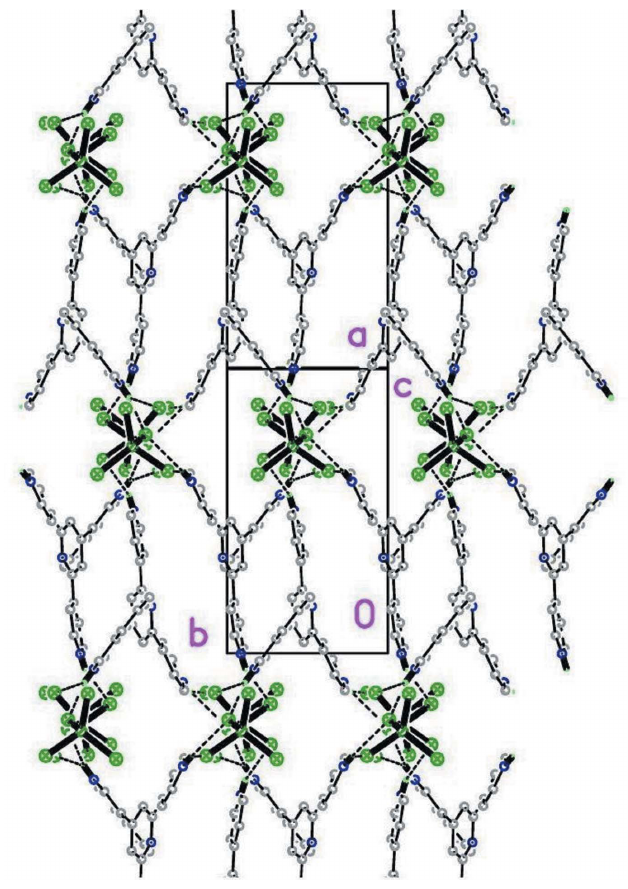
Figure 3 Same as Fig. 2, but shown along the plane normal, roughly